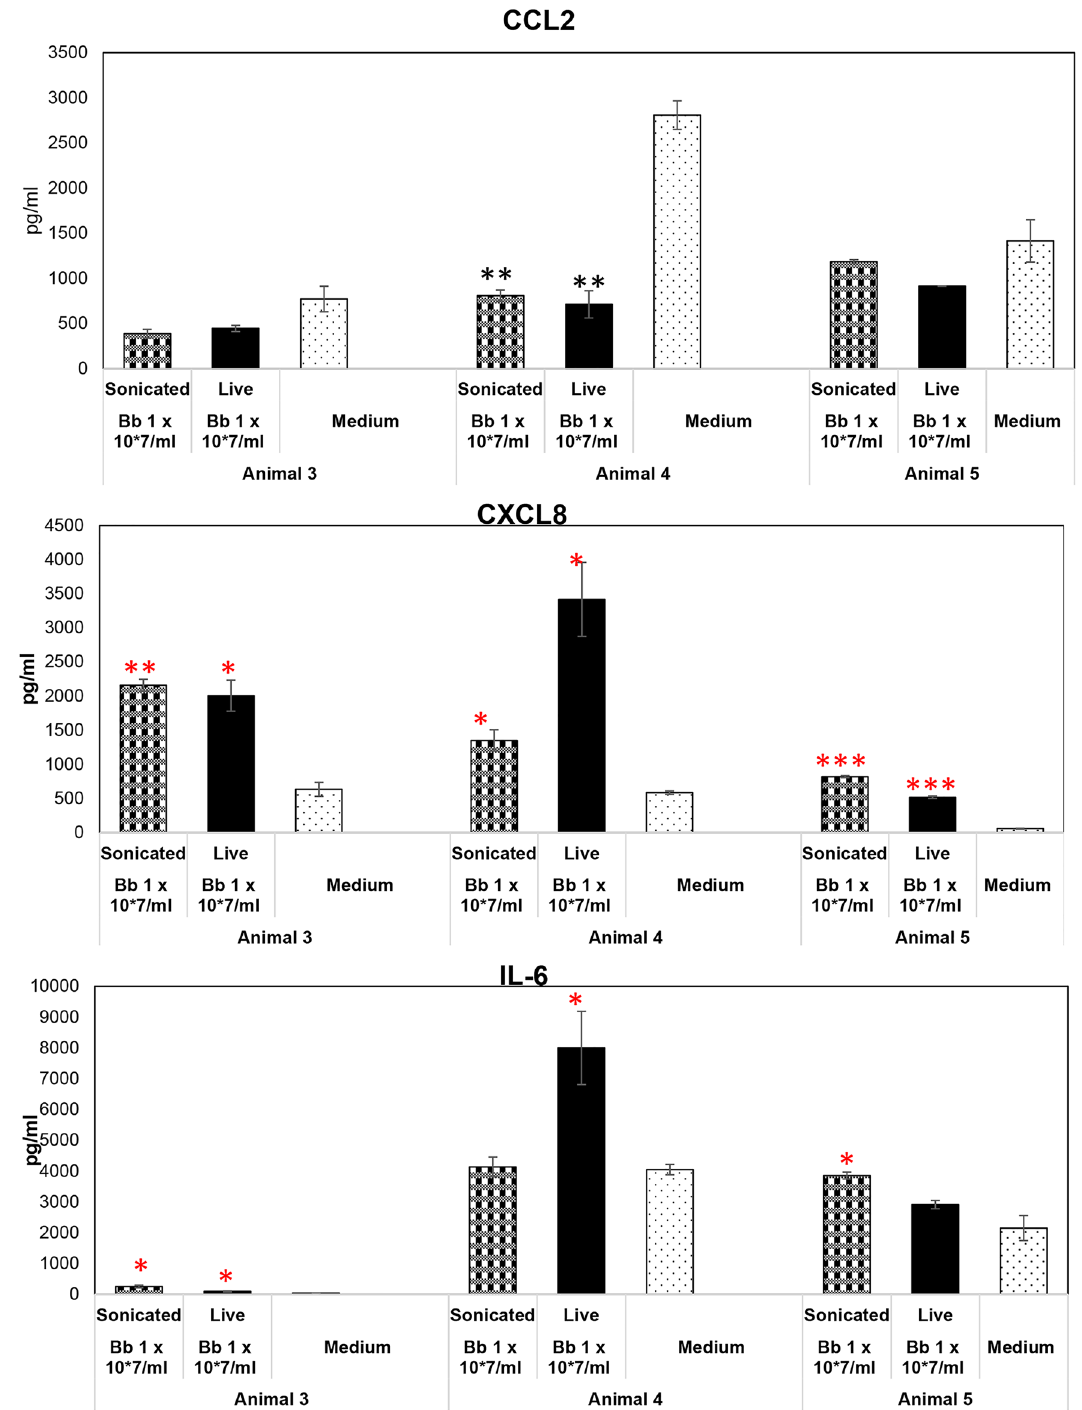
Figure 2. Effect of non-viable B. burgdorferi on inflammatory mediator production from the DRG. Rhesus DRG tissues were exposed to live or sonicated B. burgdorferi for 4 h. Supernatants were analyzed for CCL2, CXCL-8 and IL-6. Results from tissues obtained from 3 animals is shown. ***p < 0.001; **p < 0.01; *p < 0.05. Significantly increased levels over medium control is denoted by the red asterisks. Black asterisks represent significantly lower levels compared to medium control. Bars represent standard